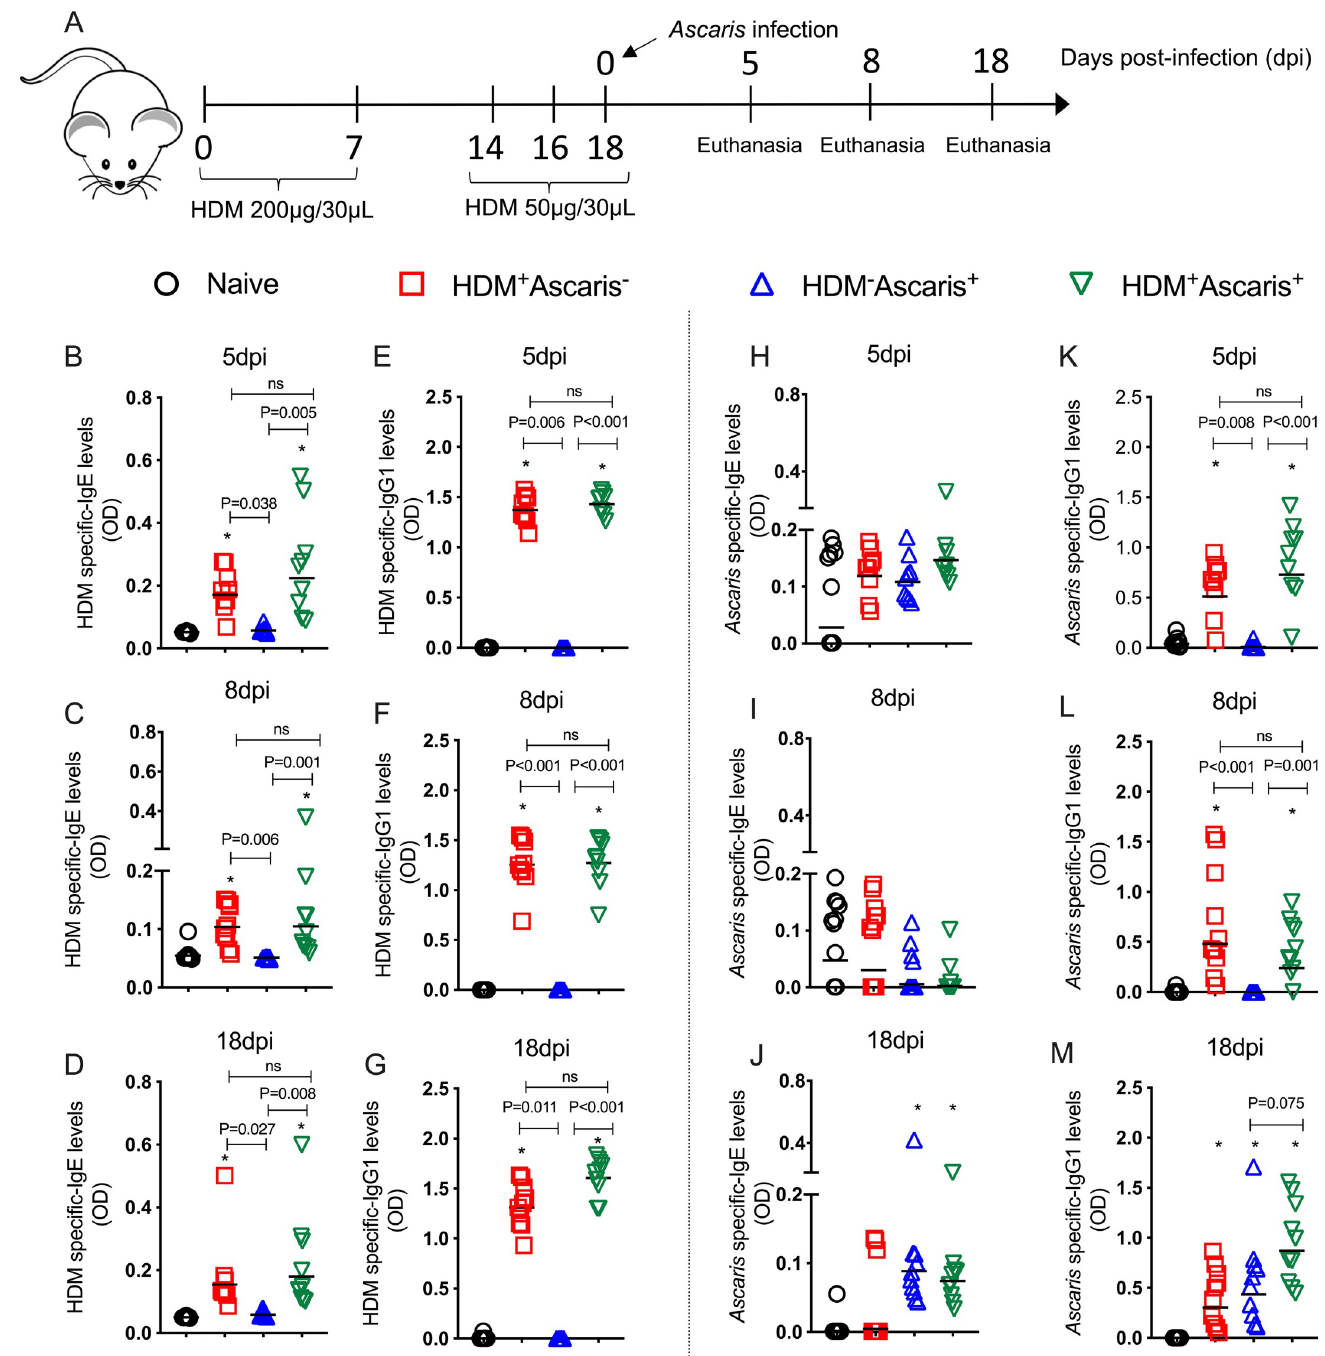
Fig 1. HDM-allergic sensitization drives a marked IgE and IgG1 antibody response that cross-react with helminth Ascaris antigens. Experimental design scheme for HDM-allergic sensitization followed by Ascaris infection in Balb/c mice (A). For the x axis, we used the number of days post infection with Ascaris (5, 8 and 18 dpi that also represent the number of days after the fifth and last sensitization with house dust mite extract. HDM-specific IgE (B-D) and IgG1 (E-G) and Ascaris -specific IgE (H-J) and IgG1 (K-M) levels were measured at day 5 (n = 9 mice/group), day 8 (n = 10 mice/group) and day 18 (n = 10 mice/group) in the sera of non-allergic and non-infected naive mice [HDM - Ascaris - ( O )]; allergic but not infected mice [HDM + Ascaris - ( □ )]; non-allergic but infected mice [HDM - Ascaris + ( Δ )]; and, allergic and infected mice [HDM + Ascaris + ( r )]. Each symbol represents a single mouse and the horizontal bars are the geometric means. P values are indicated in each graph. Kruskal-Wallis test followed by Dunn’s Multiple Comparison Test was used for all comparisons and � indicates significantly different (p < 0.05) from na ï ve (HDM - Ascaris - )